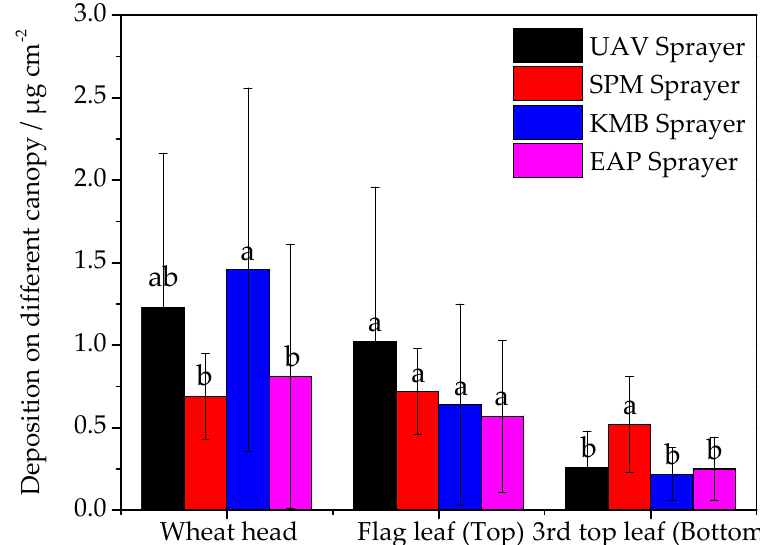
Figure 4. Deposition of four sprayers on the different canopies of wheat. Bars with different letters are significant different, Duncan’s test, p < 0.05.